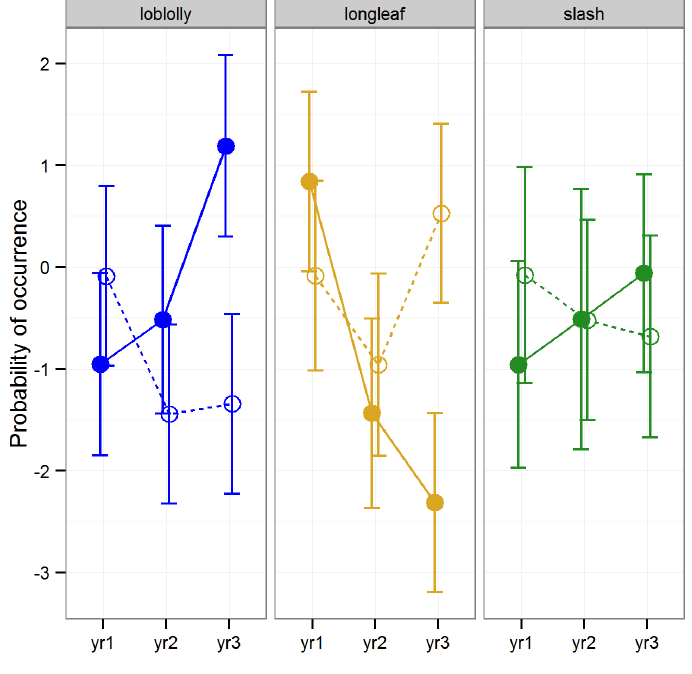
Figure 7. Predicted mean and standard errors of Acari occurrence during three years of seasonal pitfall trapping in pine plantations in North Florida against fixed-effects from the full model to display trends; raked stands are displayed with open circles and dashed lines, intact stands with solid circles and lines; 2008 as yr1, 2009 as yr2 and 2010 as